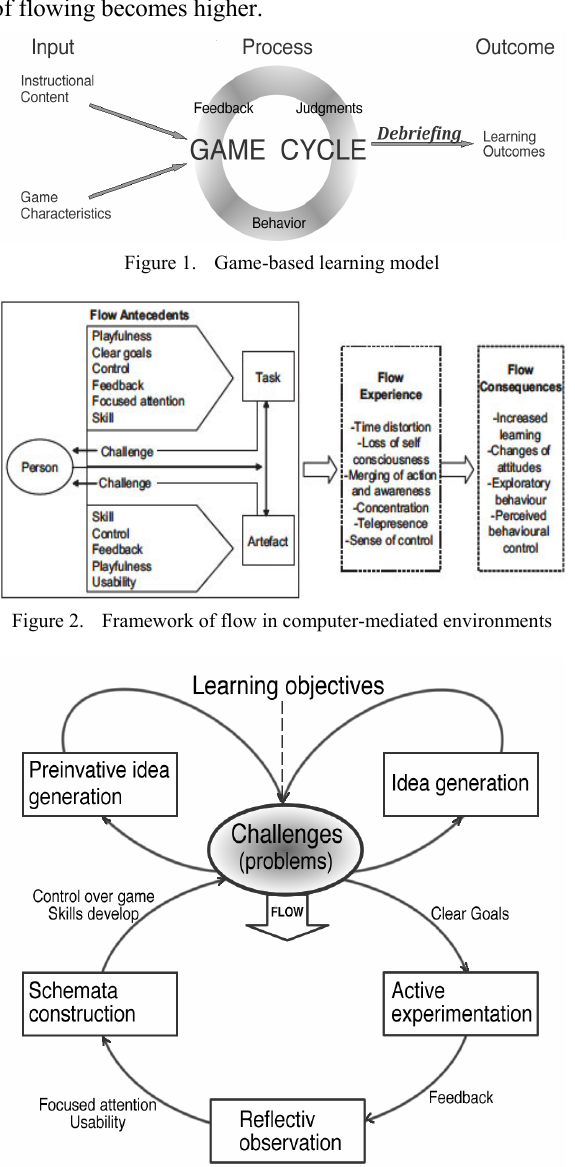
Figure 3. Game-based learning